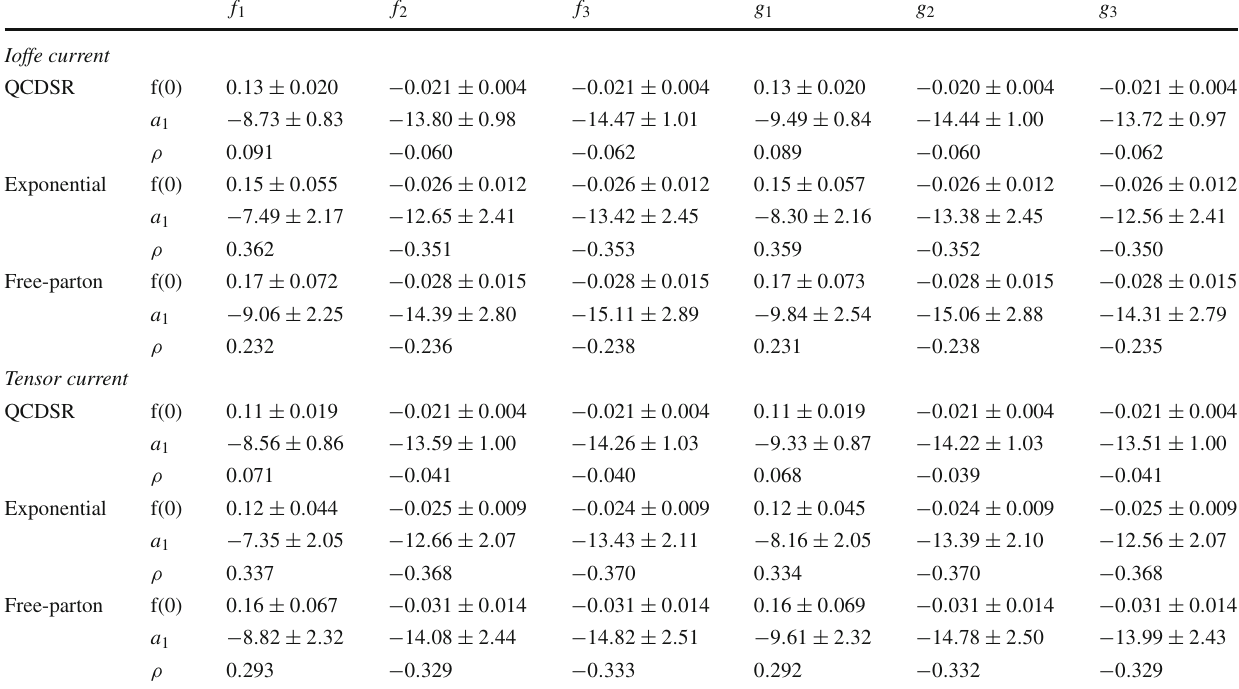
Table 3 The z -fit parameters, namely f ( 0 ) and a 1 , as well as the correlation coefficient ρ between them obtained from LCSR for (cid:2) b → p under two interpolating current (Ioffe and tensor) with QCDSR LCDA models of (cid:2) b